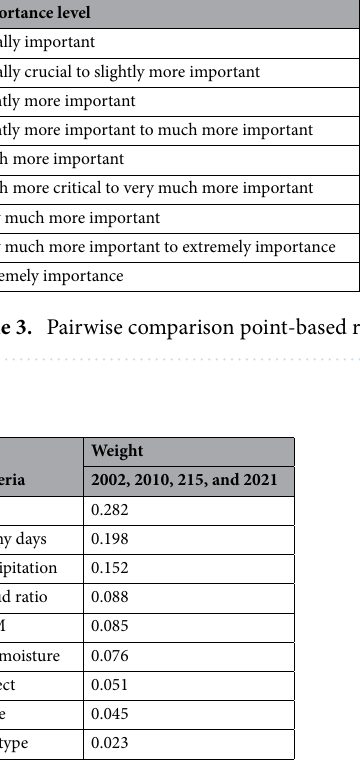
Table 4. Various predisposing variables for frost-affected areas mapping and their weights using the ANP.